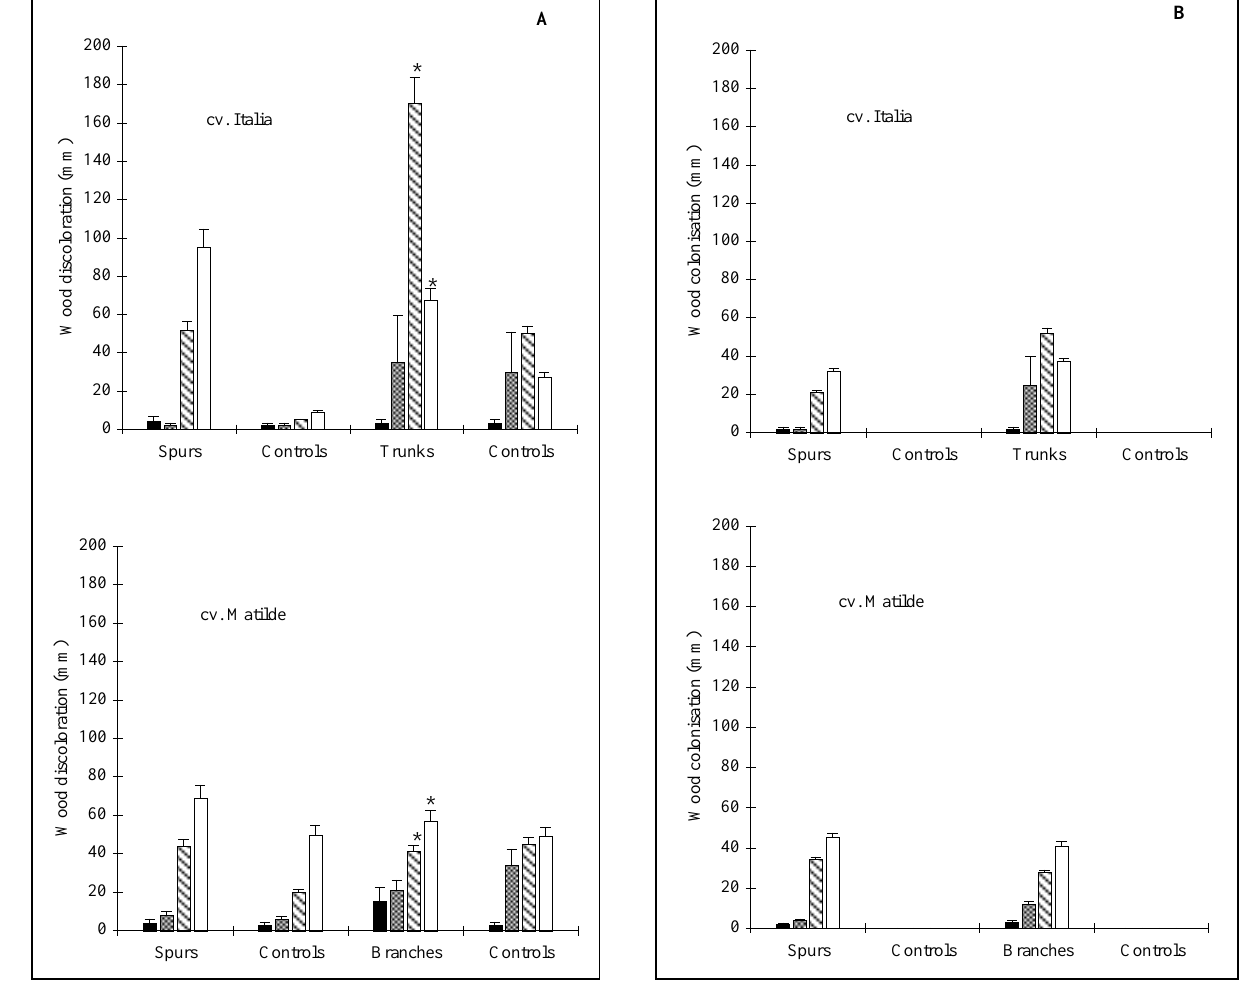
Fig. 2. A. Extent of wood discoloration in spurs and trunks of 6-year-old grapevines cv. Italia or in spurs and branches of 9-year-old grapevines cv. Matilde, 3 to 8 months after inoculation with F. punctata . B. Extent of wood colonisation by F. punctata , based on successful re-isolation of the pathogen. An asterisc (*) indicates the appear- ance of the first signs of spongy wood decay (white rot). Data are the means of 5 replicates ± SE ( April, June, July, September,